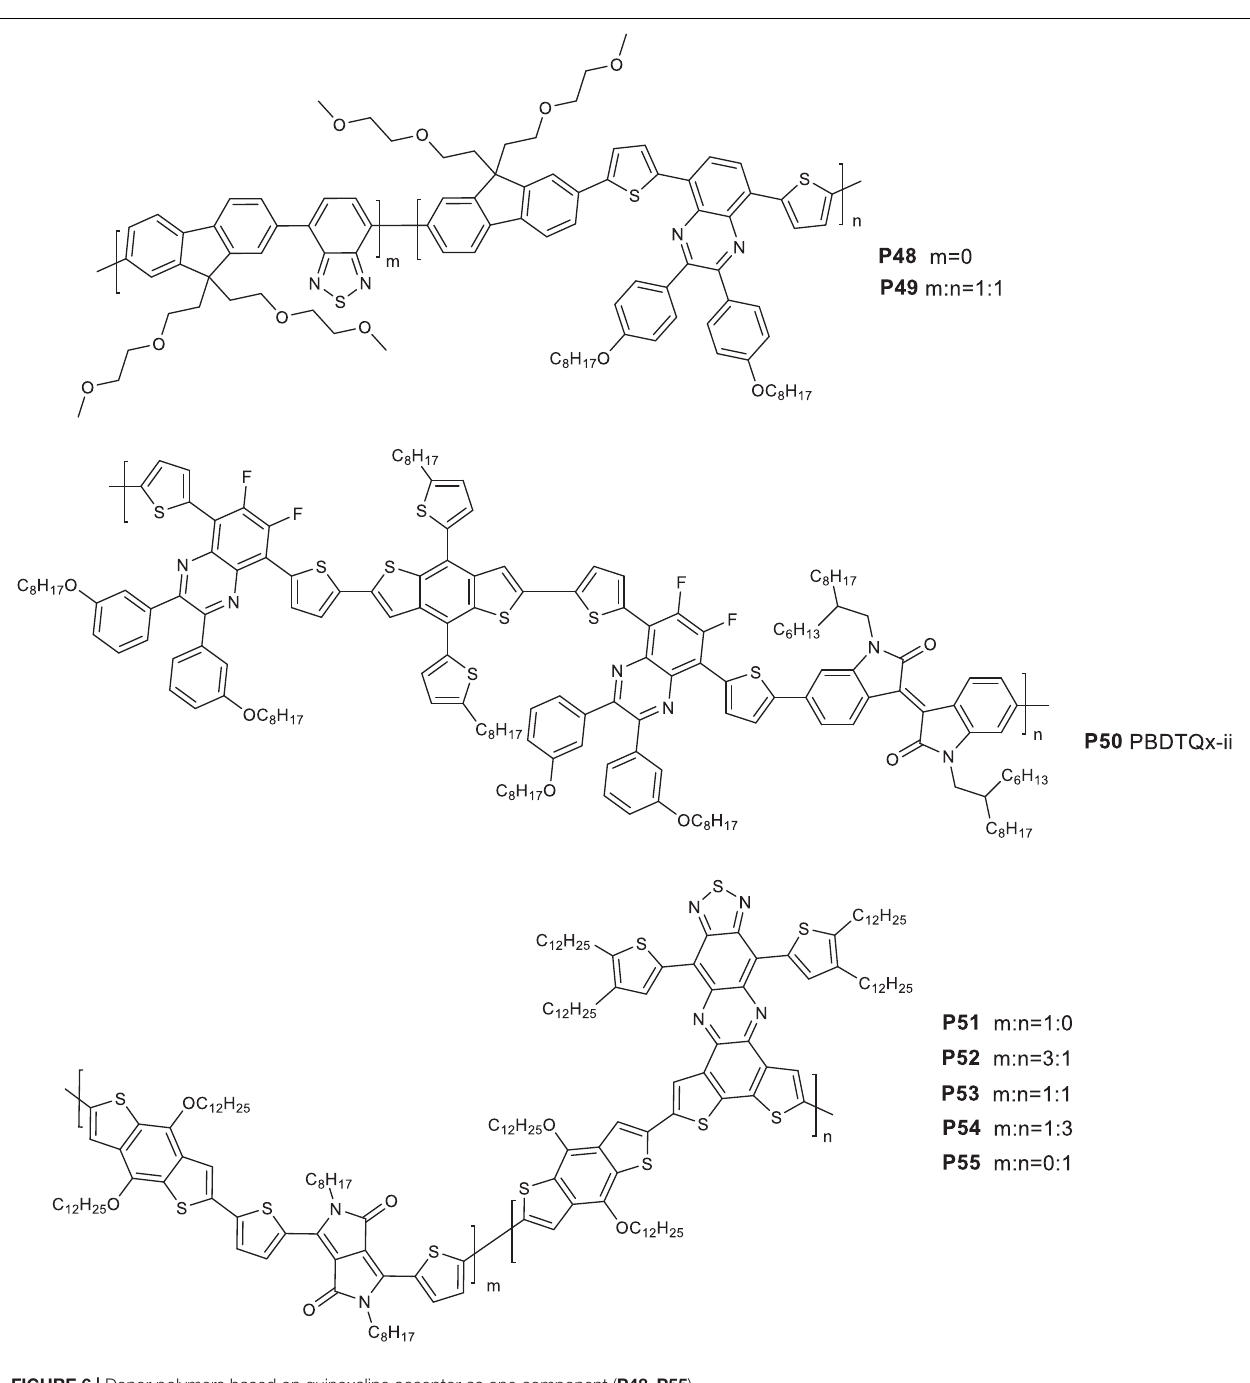
FIGURE 6 | Donor polymers based on quinoxaline acceptor as one component ( P48 – P55 ).